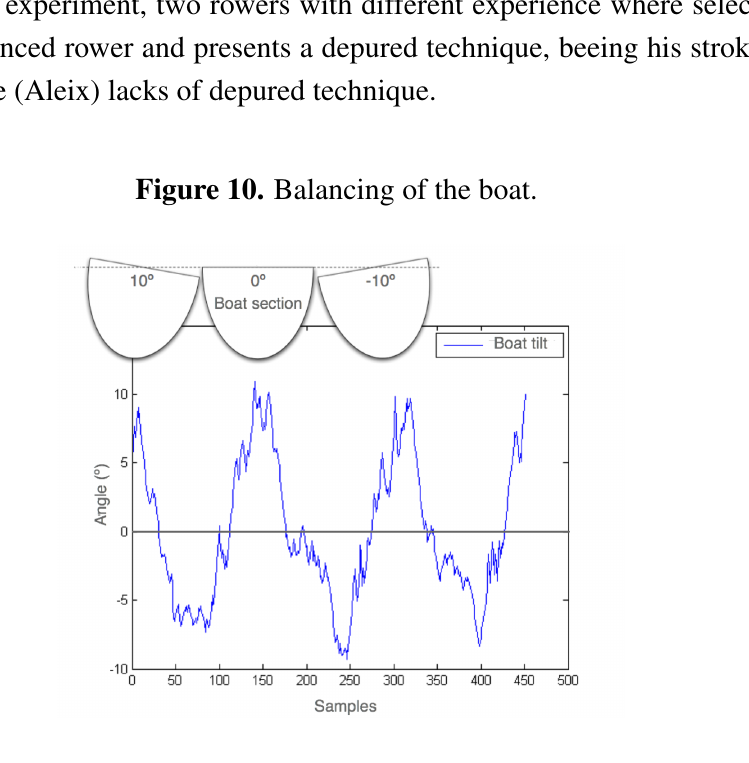
Figure 11. Stroke angles of two sportsman during three